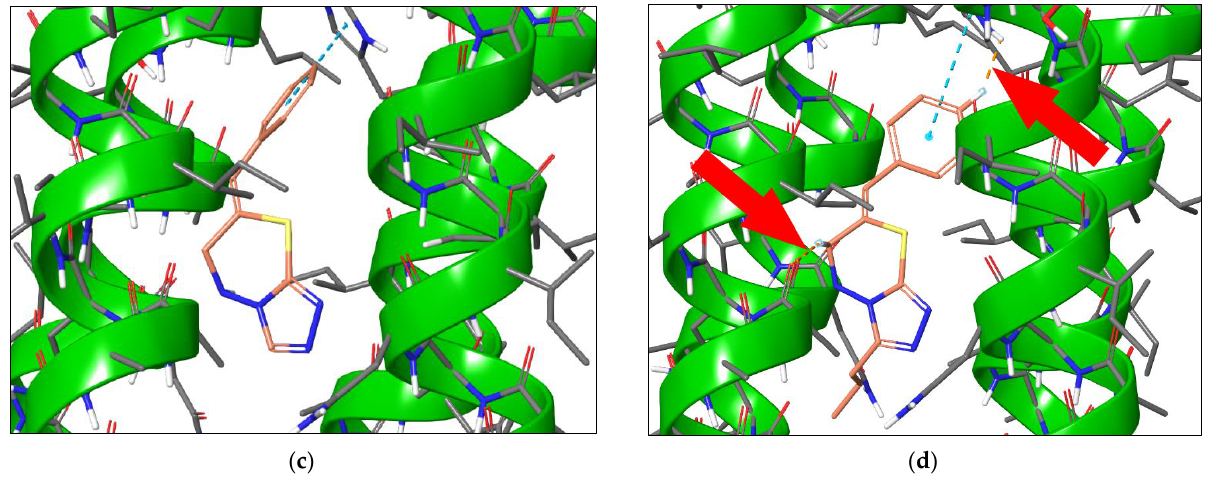
Figure 10. Binding poses of ( a ) 2a ; ( b ) 2d ; ( c ) 8a and ( d ) 8d in M2 channel active cavity, orange dashed line—strained protein-ligand contact (highlighted by red arrow), blue dashed line—pi-stacking interaction.